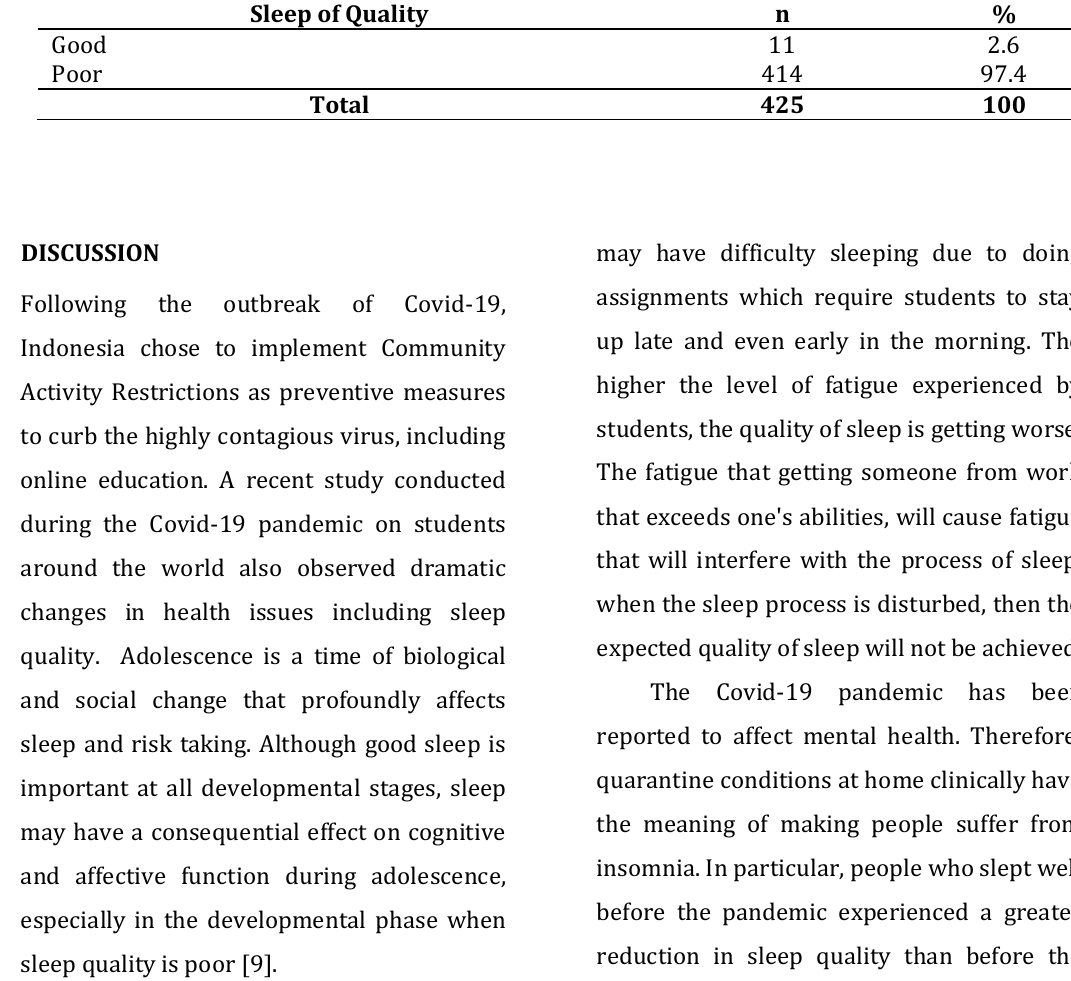
Sleep of Quality